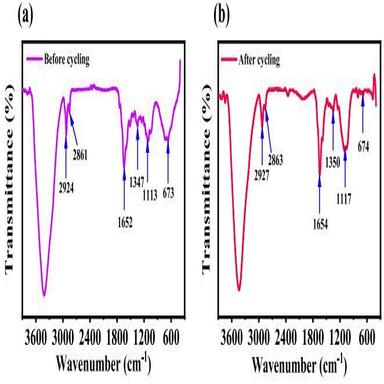
FT-IR spectra of PDI-NDI-PDI/GF electrode (a) before and (b) after 10,000 GCD cycles.